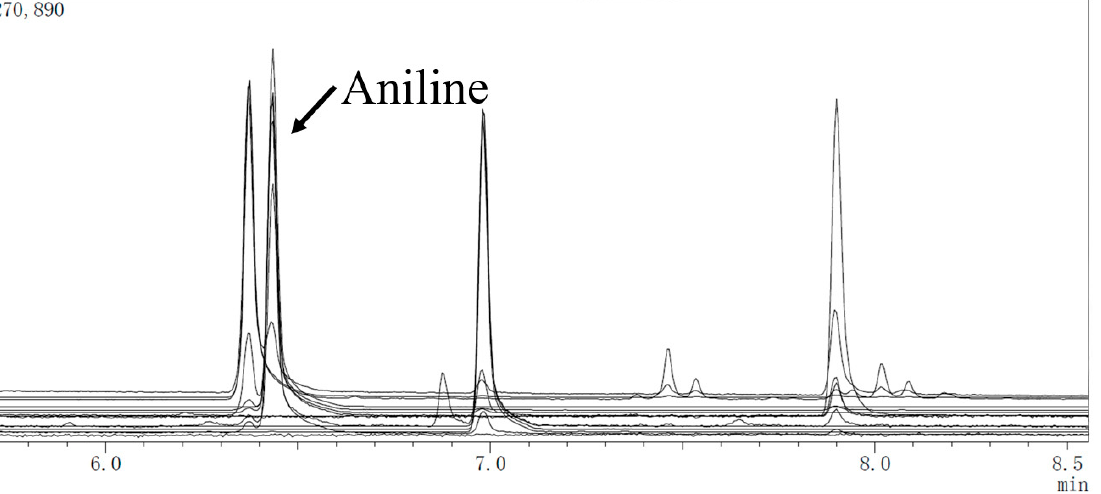
Figure 2. GC-MS extracted ion chromatograms for aniline under full scan mode. The peak time of aniline molecule is 6.55 min.